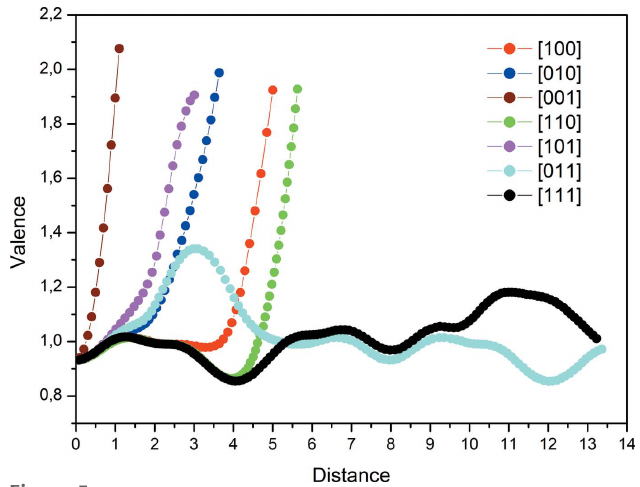
Figure 5 Ionic pathway valence curves of the title compound.